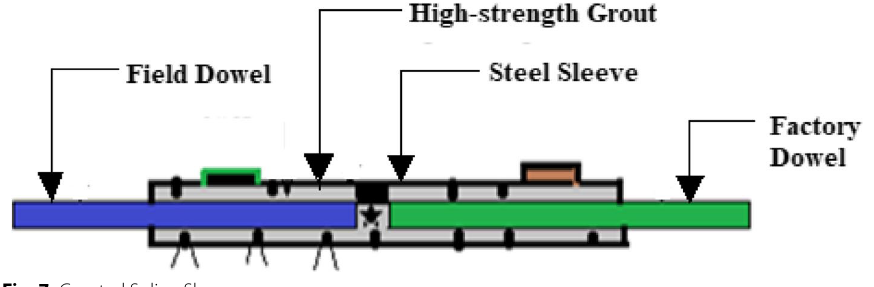
Fig. 7 Grouted Splice-Sleeve